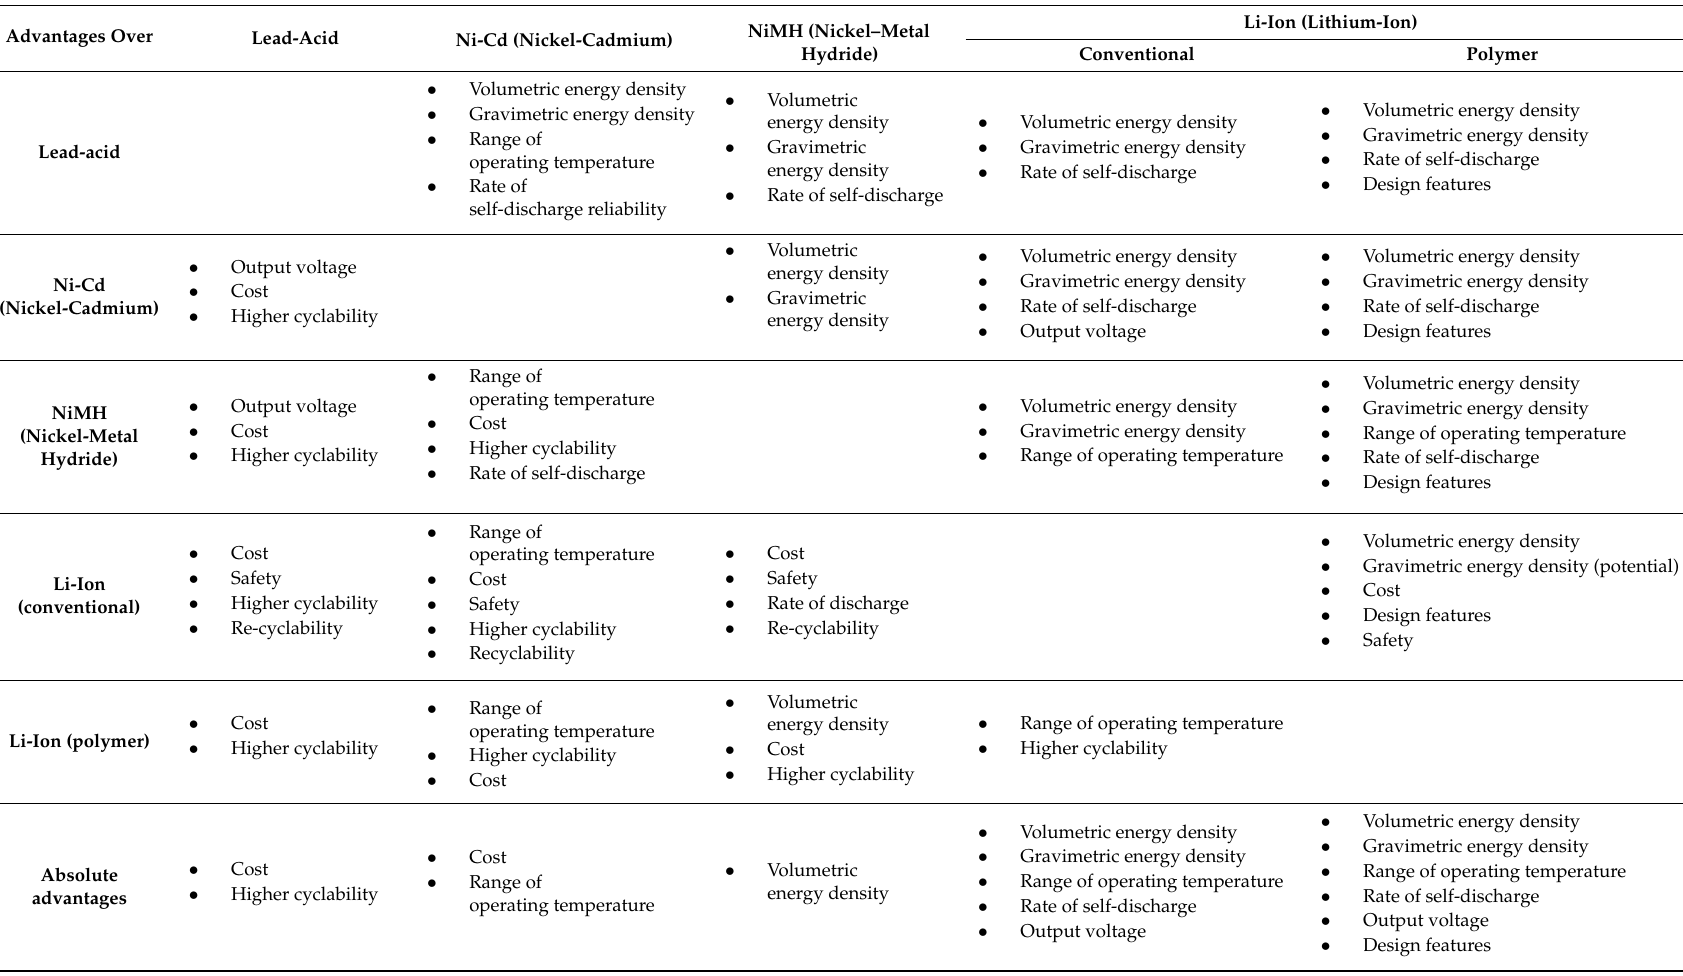
Table 7. Cross comparison of different battery types to show relative advantages. Adapted from